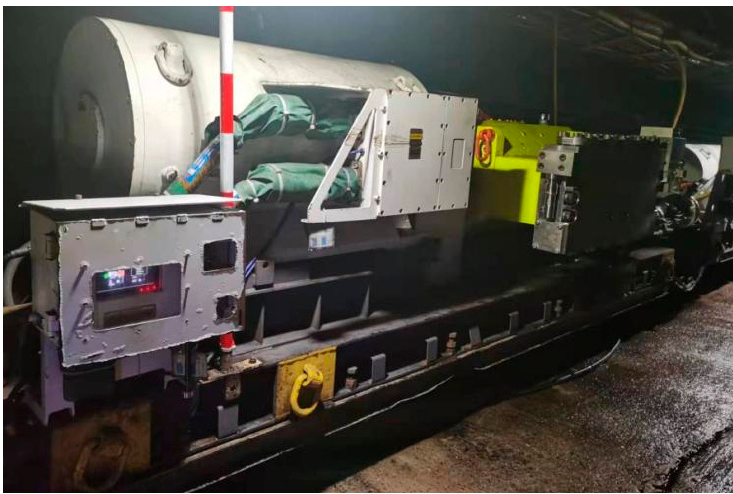
Figure 13. Underground test setup for the newly developed reciprocating